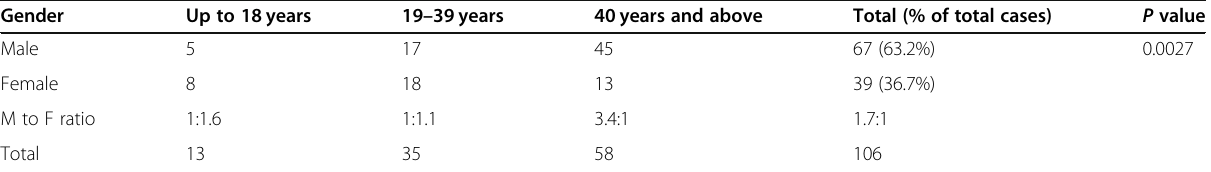
Table 1 Demographic distribution of patients undergoing renal biopsy Gender